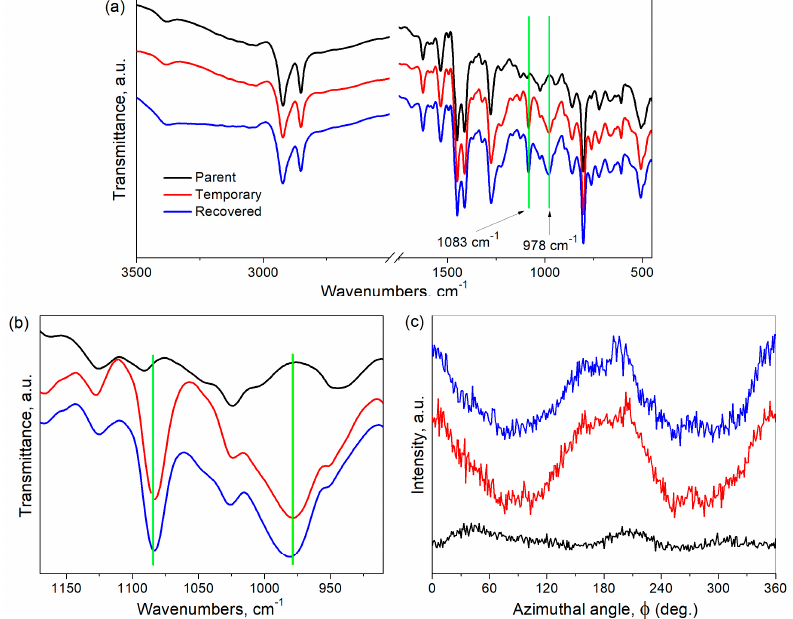
Figure 6. FTIR spectra ( a , b ) and intensity traces of the reflections around the azimuth ( c ) of the parent, temporarily shaped and recovered C10-PBI.